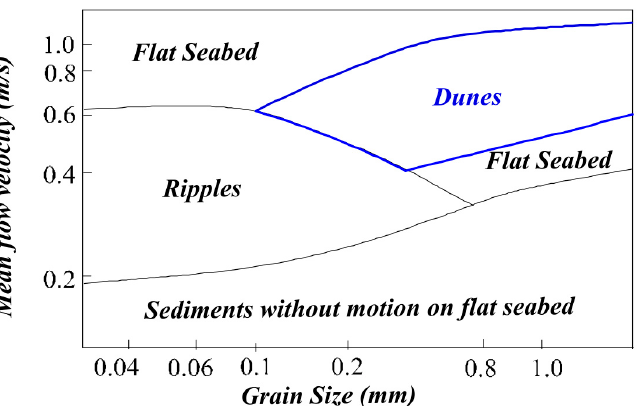
Figure 2. Correlation between the flow velocity, grain size sediment, and the sedimentary structure formed, adapted from [25].